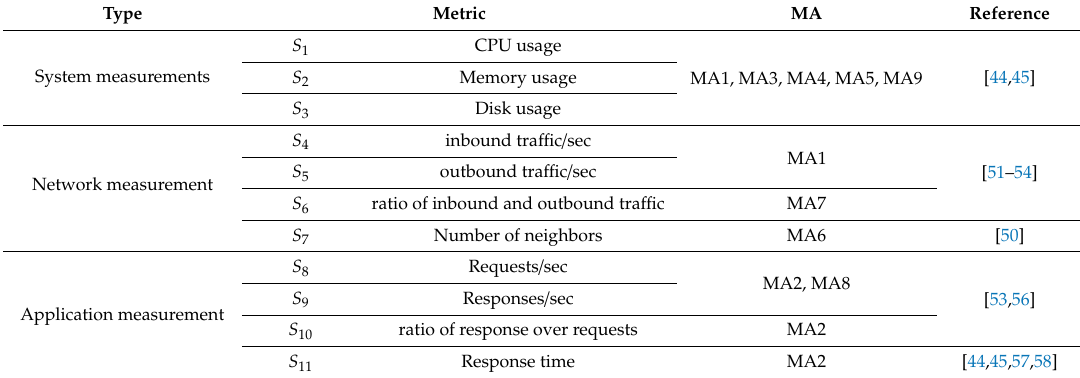
Table 3. Correlation between MAs and metrics.